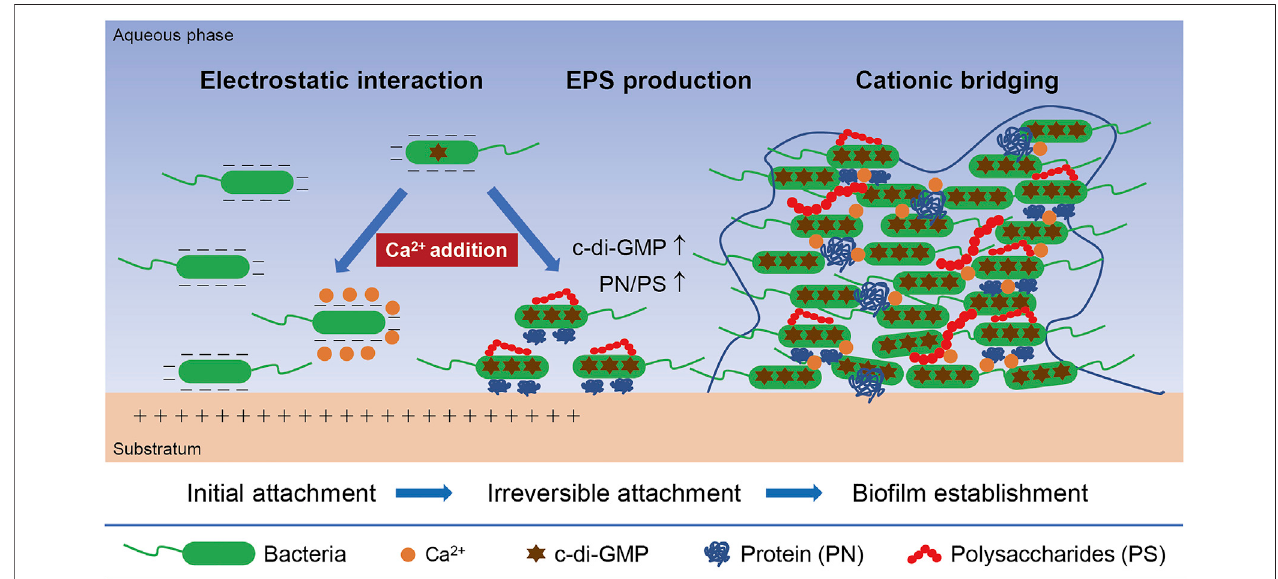
FIGURE 8 | A conceptual illustration of the mechanisms inherent in the calcium-mediated regulation on bacterial bio fi lm formation.